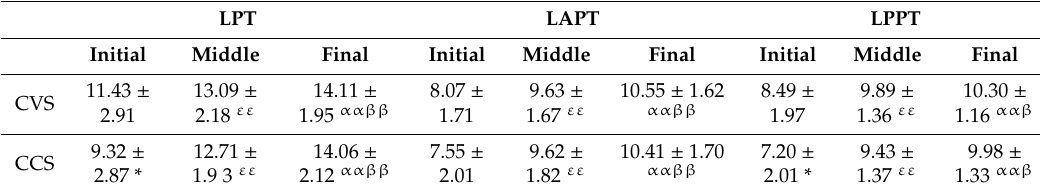
Table 3. Di ff erences in the inclination angle between the convex side (CVS) and concave side (CCS) among the initial, middle and final